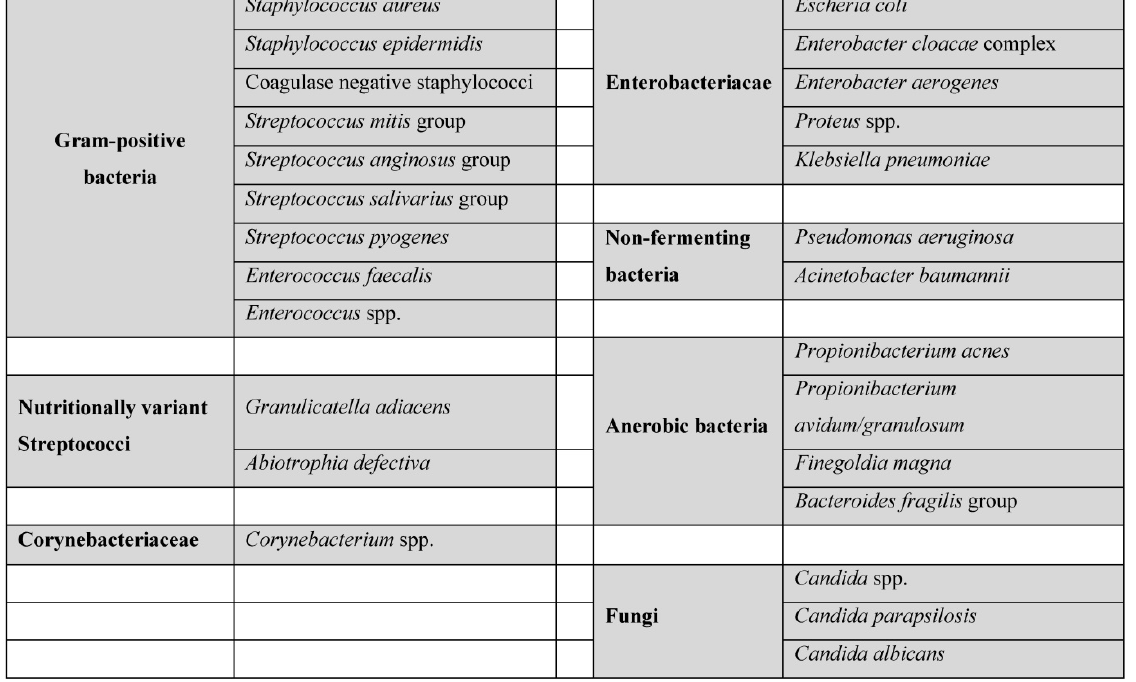
Figure 1. Coverage of the clinically relevant pathogens detected by the Unyvero ® Multiplex PCR cartridge system. The most relevant pathogens and their sub-groups which have been reported in studies are shown. Modified account based on Curetis Unyvero ®